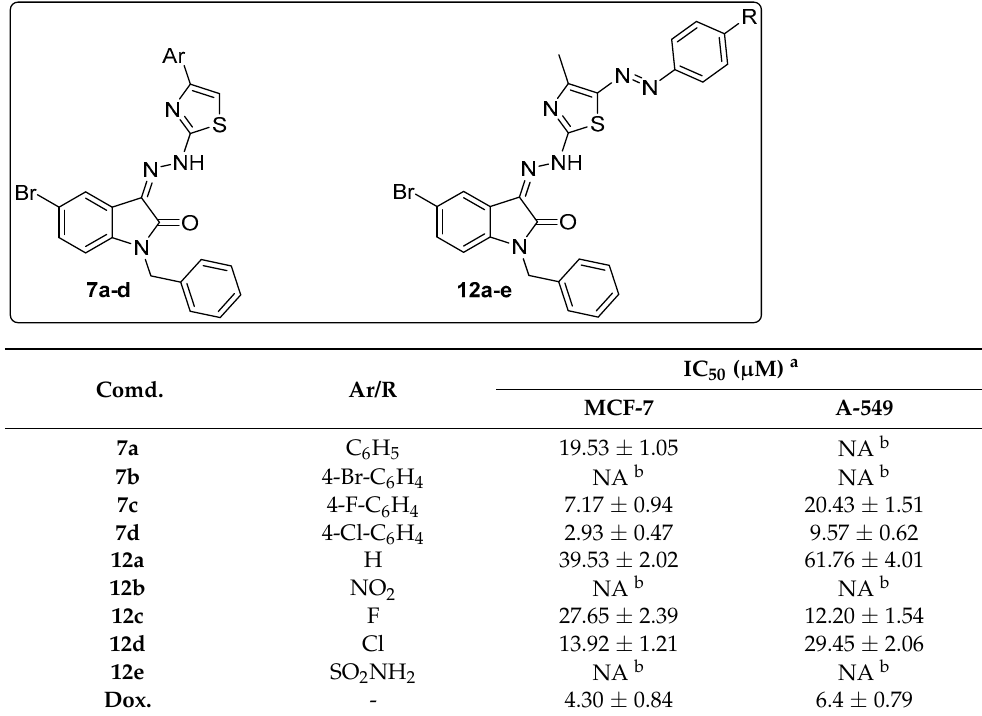
Table 1. In vitro anticancer activities (IC 50 ) for the synthesised N -benzyl-5-bromoindolin-2-one